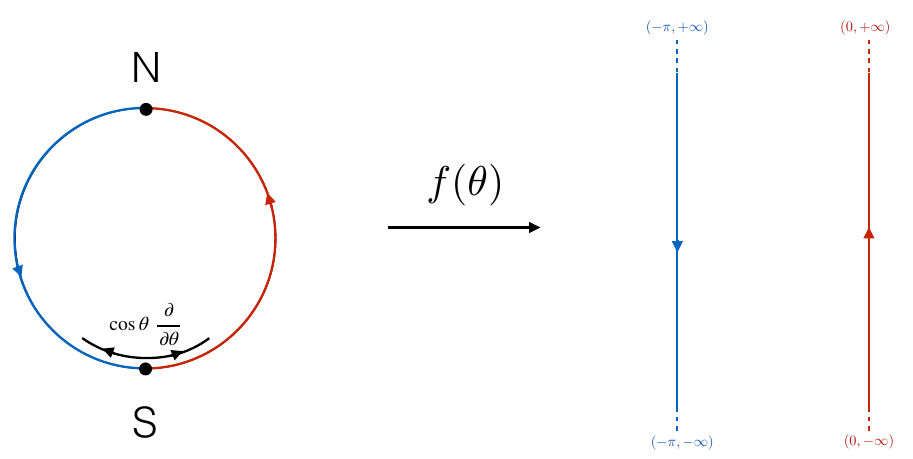
R introduced in Figure 3 . The operator-state map in 1D CFT proceeds via the map S 1 S 0 ! (cid:2) eq. (3.6). The semi circle in red is mapped to one copy of R shown in red, situated at (cid:27) = 0, while the blue semi-circle is mapped to the blue copy of R , situated at (cid:27) = (cid:25) . The Hamiltonian @ is @(cid:28) (cid:0) mapped to cos (cid:18) @ and thus generates radial evolution as shown around the south pole. Modulo the @(cid:18) R this is the analog of radial quantisation in higher subtlety of mapping to the disconnected S 0 (cid:2) dimensional